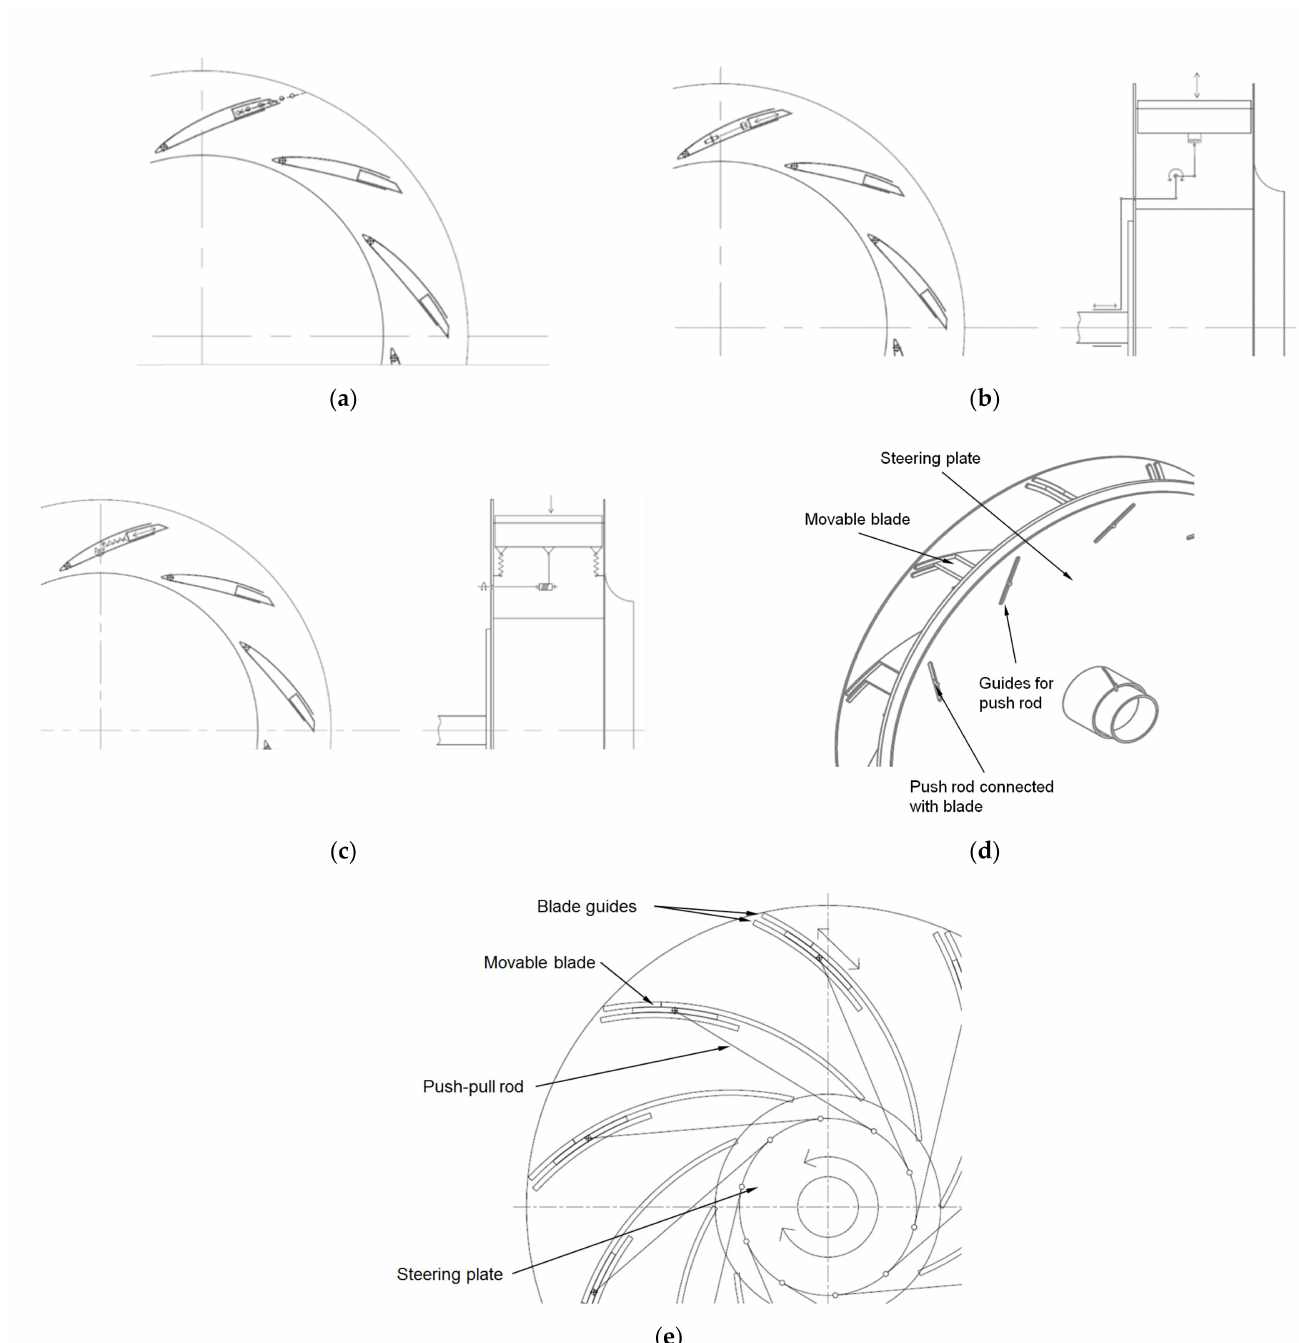
Figure 2. Concepts of adjustable length of the blade of centrifugal impeller—bolted blades position is adjusted during fan standstill ( a ), axial movement of the steering plate and bar linkage causes movement of blade ( b ), blades are pulled in with the use of cable drum ( c ), blades are adjusted with use of rotating steering plate ( d ), rotation of the steering plate and push-pull rods results in movement of blade along blade guides ( e